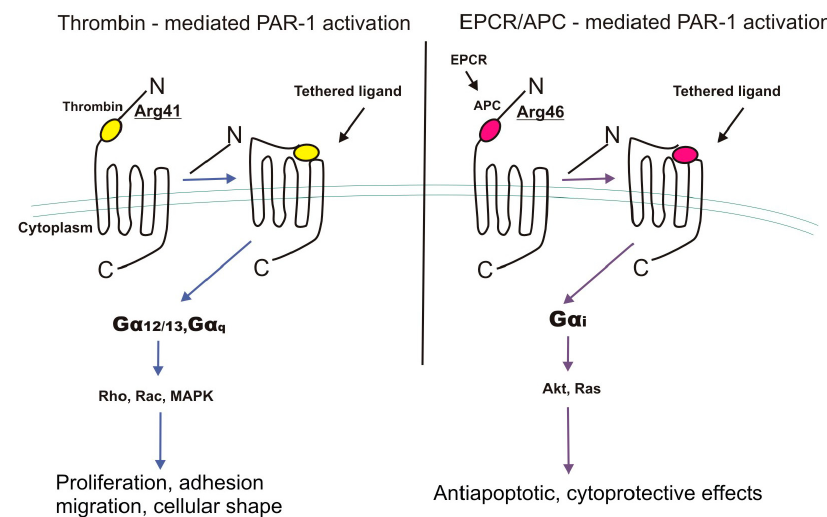
Figure 2. Distinct mechanisms of PAR-1 (protease-activated receptor 1) activation by thrombin- and activated protein C (APC)/endothelial protein C receptor (EPCR) complex resulting in different biological effects. MAPK, mitogen activated protein kinase, proteins Rho, Rac, Akt,